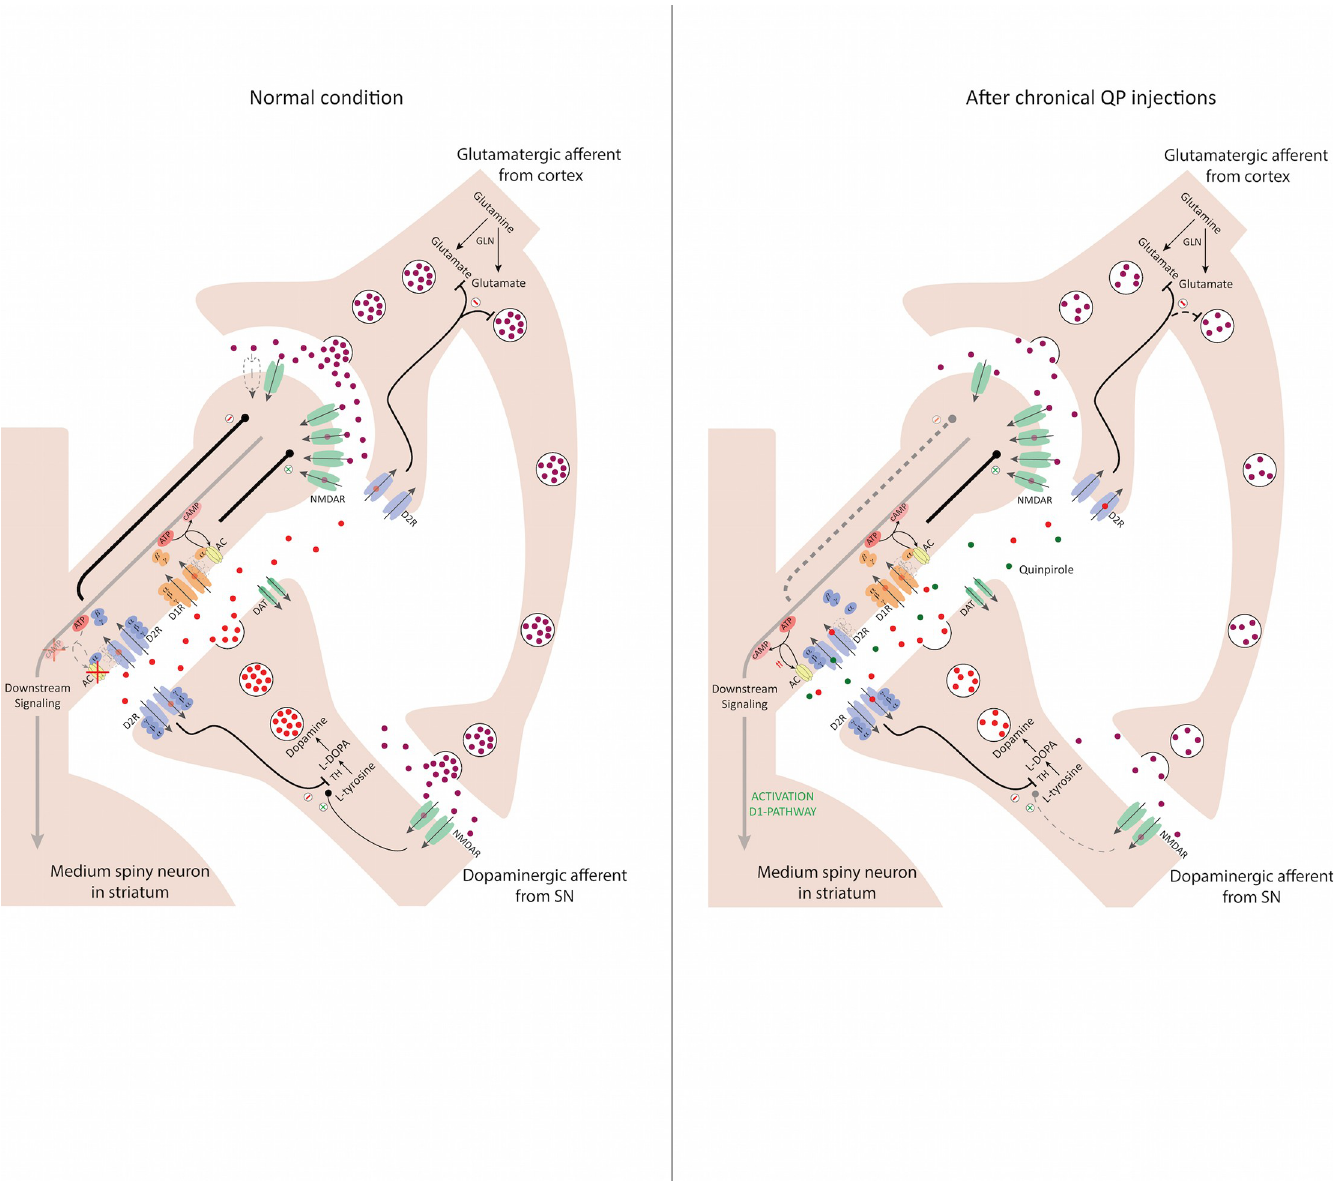
Fig 4. Chronic quinpirole exposure. A) The striatum consists for 95% out of medium spiny GABAergic neurons which branch out in a number of dendrites. On the heads of the dendrites, glutamatergic neurons connect that are often coming from the cortical regions. This then results in downstream signalling. This signalling can be modified and altered by DA-ergic neurons connecting on the branches. In the normal condition a balanced system is in place whereby release of DA will trigger postsynaptic D1 and D2 receptors. These G-coupled receptors will determine the amount of conversion from ATP to cAMP, a secondary messenger which affects downstream signalling. The triggering of the presynaptic D2-receptors results in a feedback mechanism by inhibition of tyrosine hydroxylase, responsible for the conversion of L-tyrosine to L-DOPA eventually leading to Dopamine. Likewise, the D2-receptors present on the glutamatergic neuron inhibit glutamate release which will reduce downstream signalling and further DA-release. DAT transporters participate in the reuptake of DA present in the synapse. B) A different scenario takes place when, due to constant stimulation of the D2-receptor, the receptor becomes sensitized. This will increase the inhibition on the release of DA as well as glutamate, leading to less release of both neurotransmitters. However, due to the constant activation of the D2R receptor a process called heterologous sensitization occurs whereby the consistent activation of G α i/o -coupled receptors results in a compensatory increase in adenylyl cyclase. This will result in a D2-mediated activation of the D1-pathway resulting in the displayed motor behaviour.